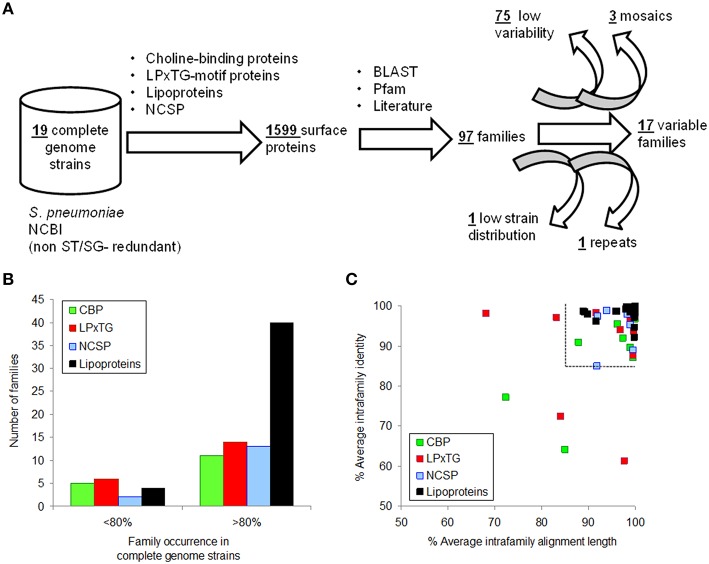
Selection of surface proteins showing inter-strain variability. (A) Procedure flowchart used to detect variable proteins. (B) Occurrence distribution of protein families according to surface anchor. (C) Identity and alignment length averages of families with an occurrence>80% in the reference genomes. The dashed lines split protein families not selected as a consequence of low variability.